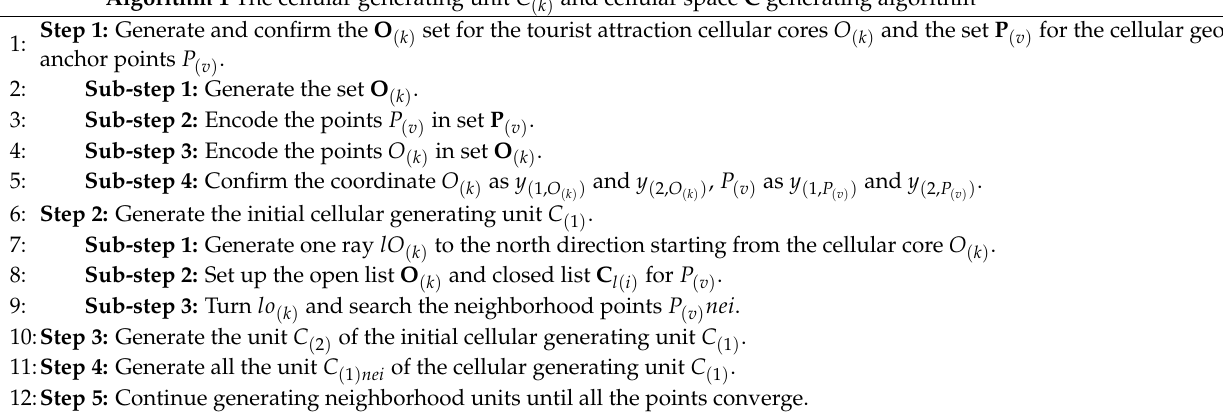
Figure 2 is an example to form the space C . Figure 2a–f illustrate the process of form-